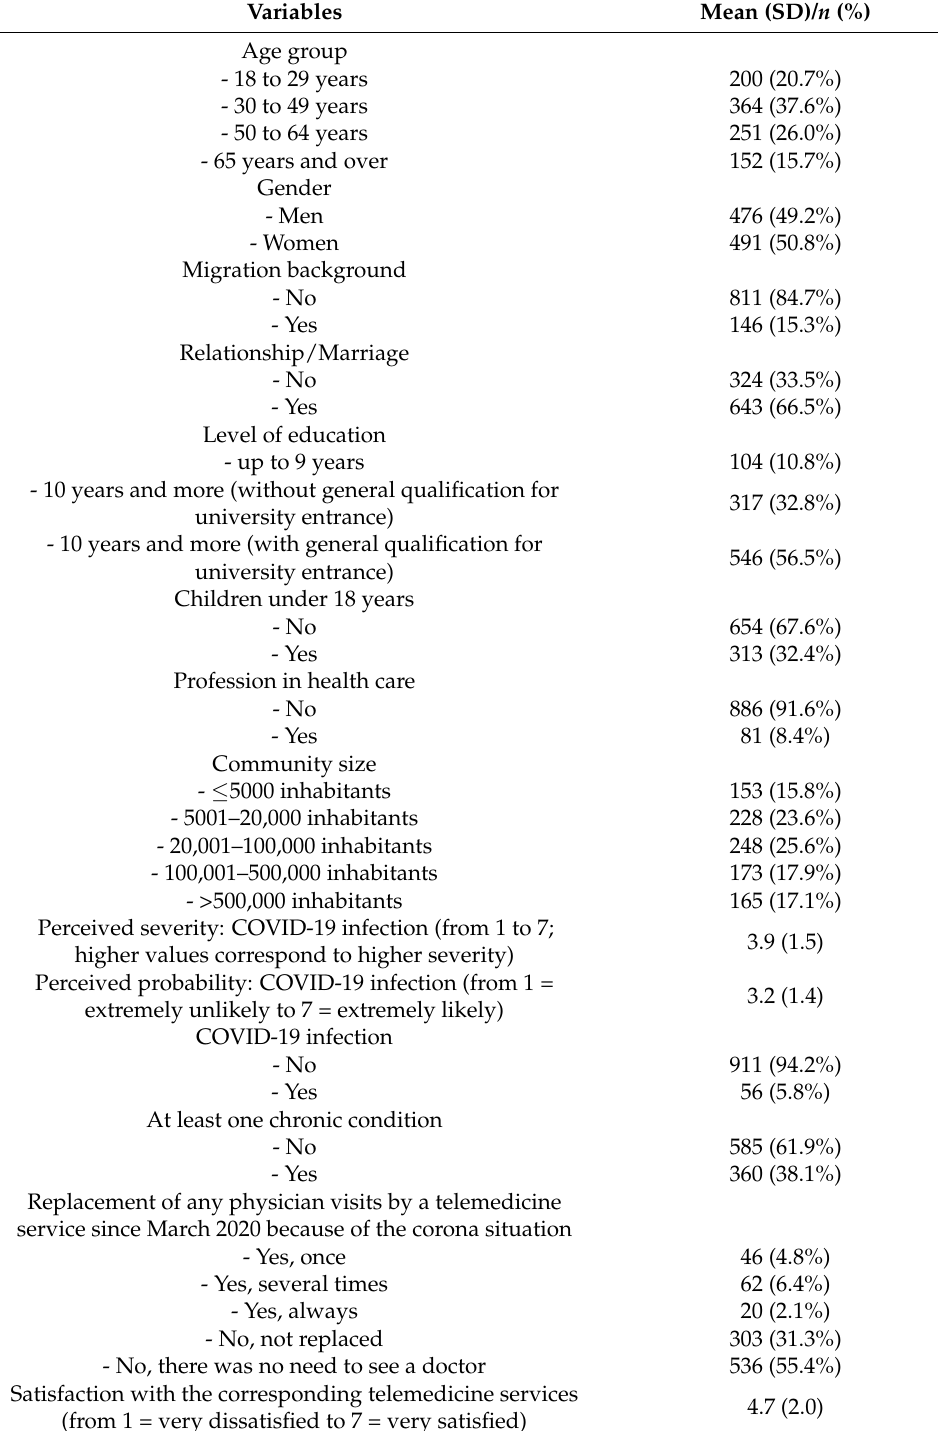
Table 1. Sample characteristics ( n =